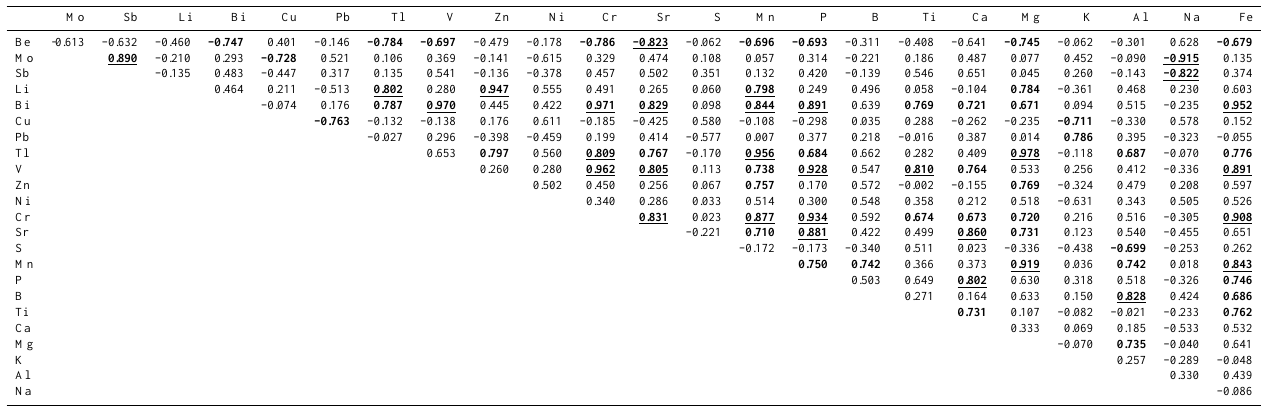
Table 5. Pearson correlation coefficients among elements (mgkg − 1 ) in the samples of the moraine profiles. Bold face numbers are significant at the 95% confidence level, underlined numbers are significant at the 99% confidence level.